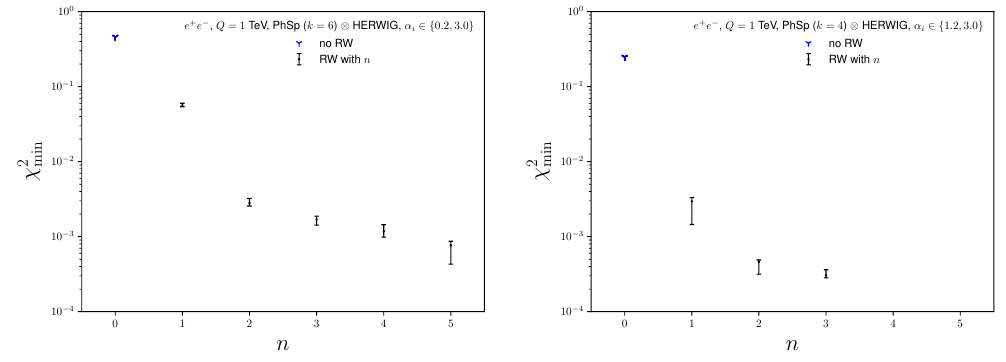
Figure 10 . Same as the right panel of (cid:12)gure 7, but obtained from k = 6-body phase space (left panel) or by restricting the domain of angularity exponents to the set (cid:11) i